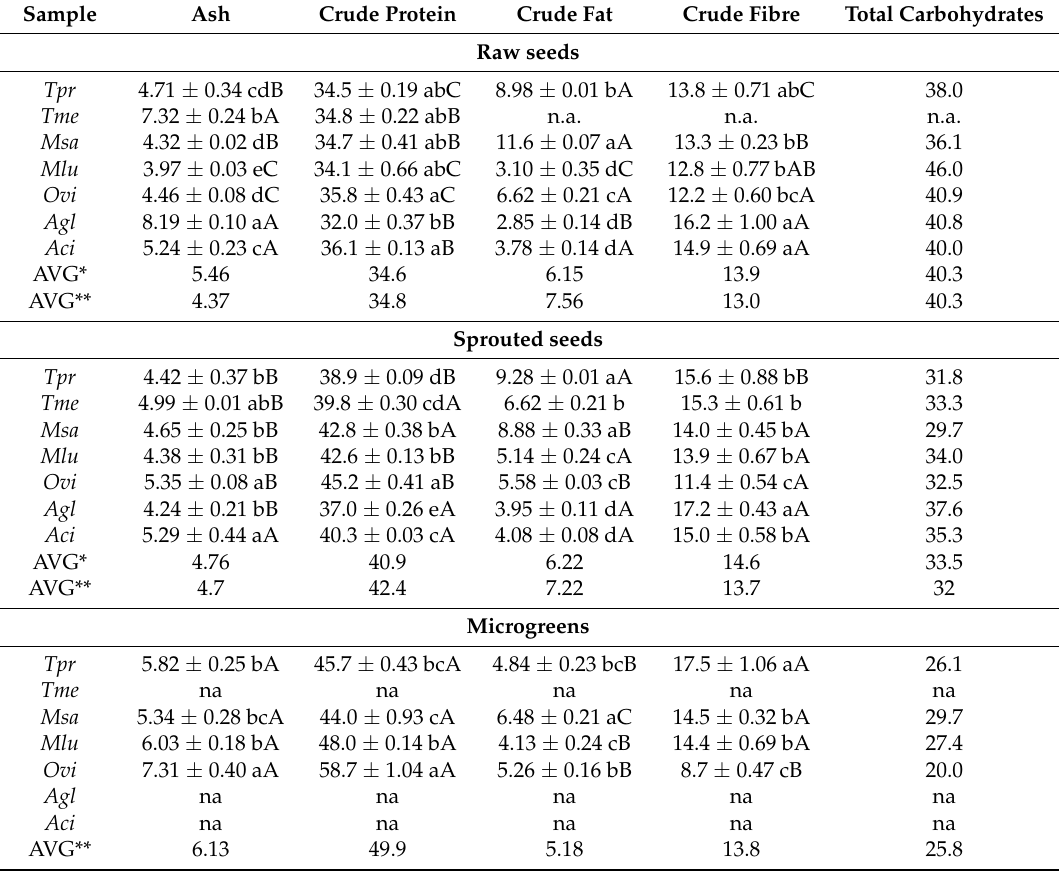
Table 1. The proximate composition (g/100 g ± SD) of raw seeds, sprouted seeds and microgreens of perennial